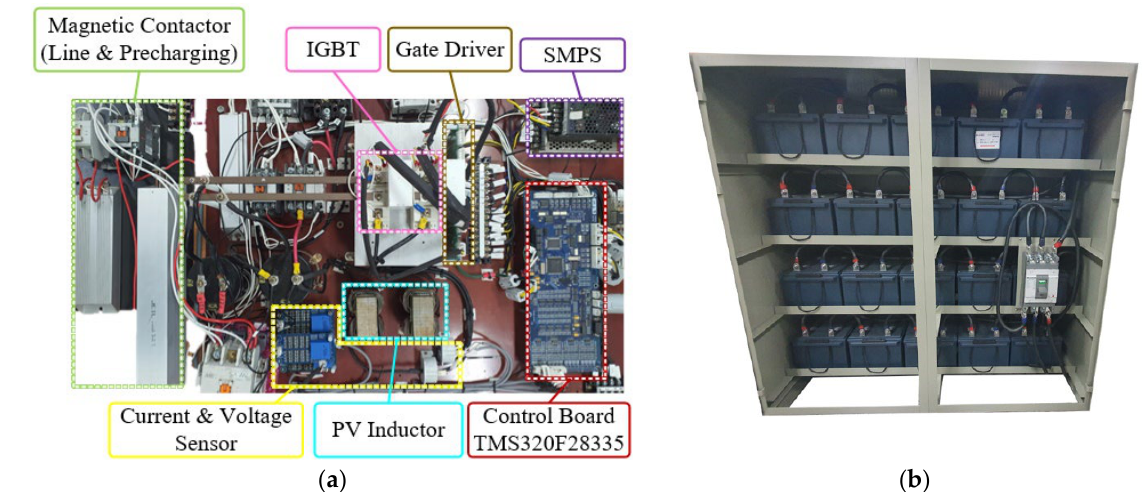
Figure 17. Energy storage system (ESS): ( a ) ESS converter; ( b ) battery for ESS.